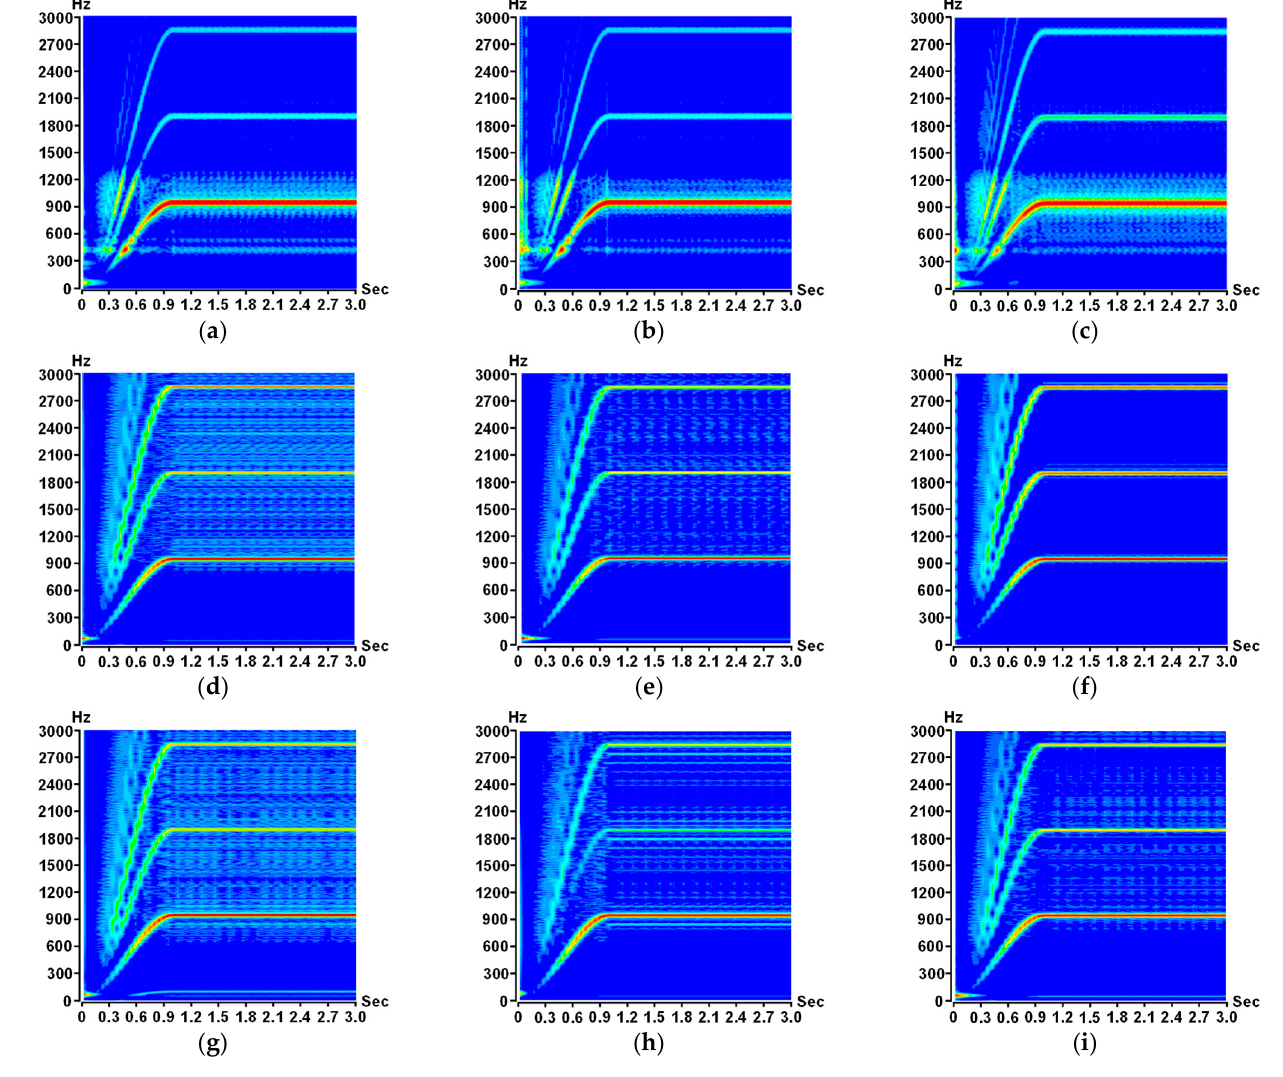
Figure 13. Noise level analysis results by case: ( a ) Initial model; ( b ) Case 1; ( c ) Case 2; ( d ) Case 3; ( e